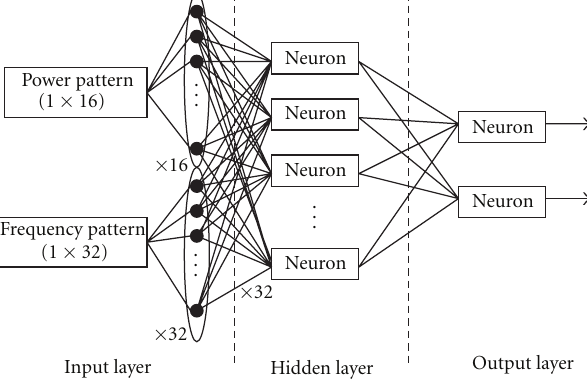
Figure 4: NN in the recognition